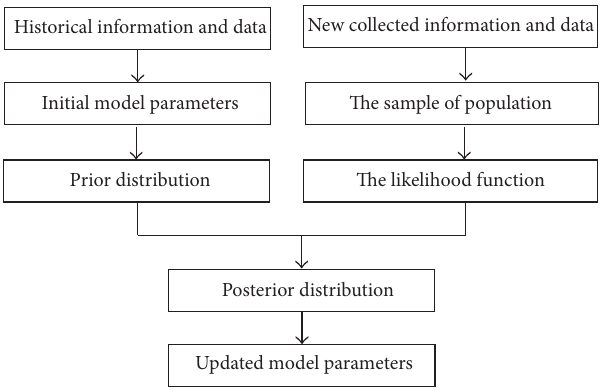
Figure1: Theframework of AI-basedapproach forupdating param-